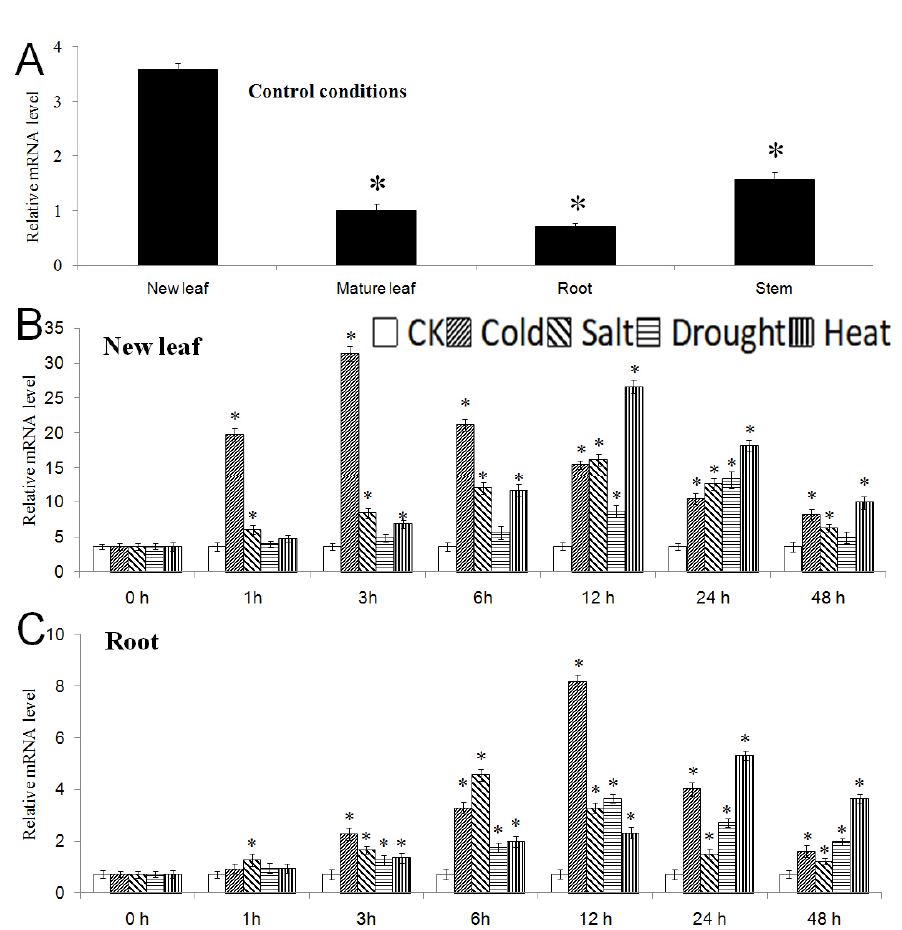
Figure 3. Expression of the MbNAC25 gene in different tissues and organs of Malus baccata. ( A ) Expression of the MbNAC25 gene in different organs under control condition. Asterisks above columns indicate significant difference compared to that in the new leaf (* p ≤ 0.05). ( B ) Expression of the MbNAC25 gene in the new leaf and ( C ) in the root under control condition (CK), low temperature, high salt, drought and high temperature. Data represent means and standard errors of three replicates. Asterisks above columns indicate significant difference compared to that in control condition (* p ≤ 0.05).